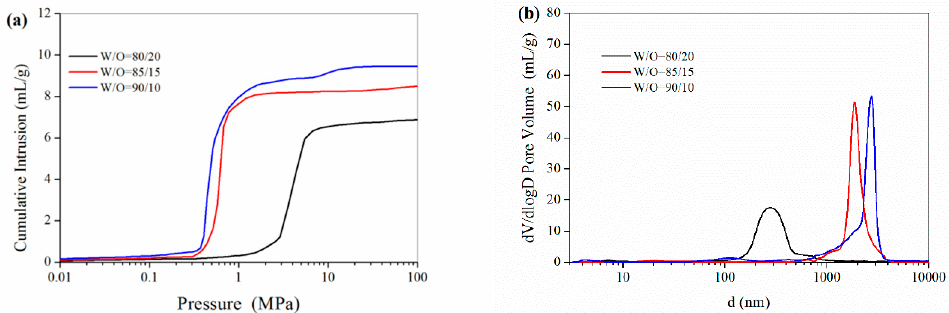
Figure 3. ( a ) Cumulative mercury intrusion traces and ( b ) Size distribution of the interconnected windows in the PolyHIPE scaffolds fabricated with different W/O ratio.